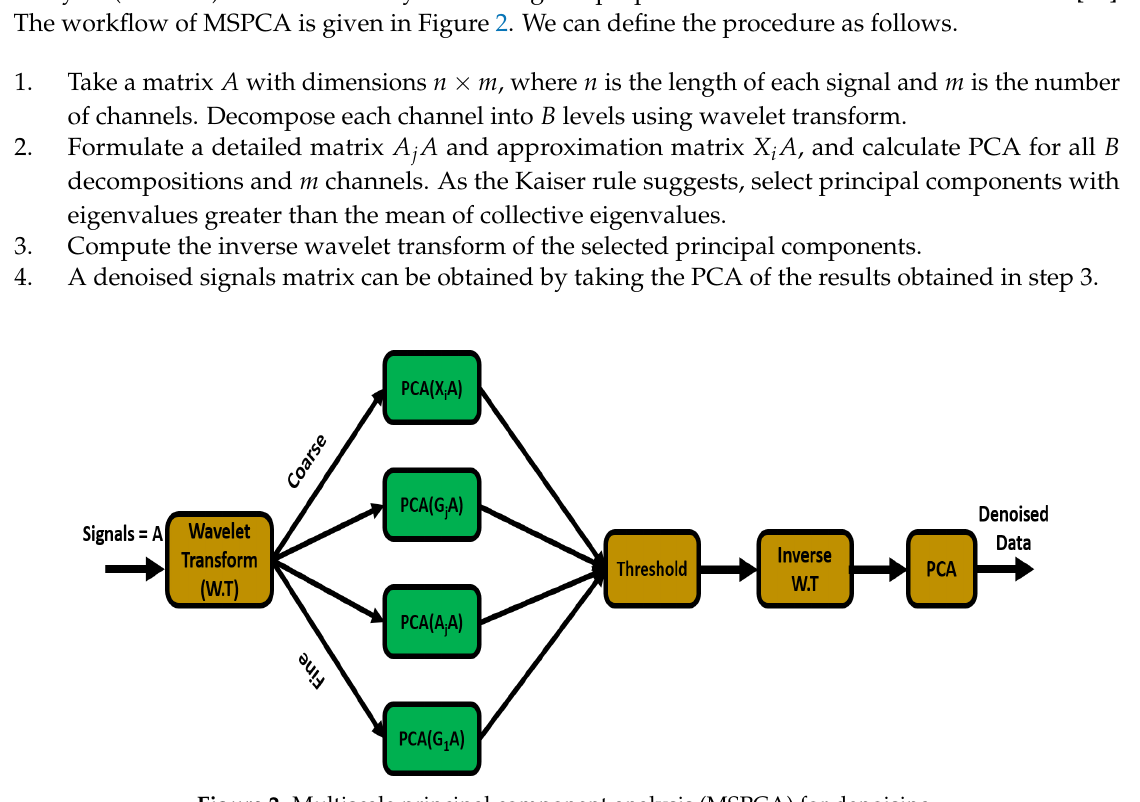
Figure 2. Multiscale principal component analysis (MSPCA) for